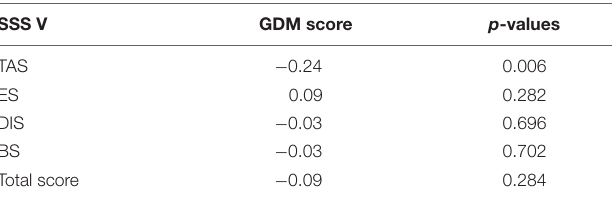
TABLE 1 | Spearman coefficients of correlation between Sensation Seeking Scale V (SSS V) and Goodness of Decision-Making (GDM) scores. SSS V GDM score p -values −